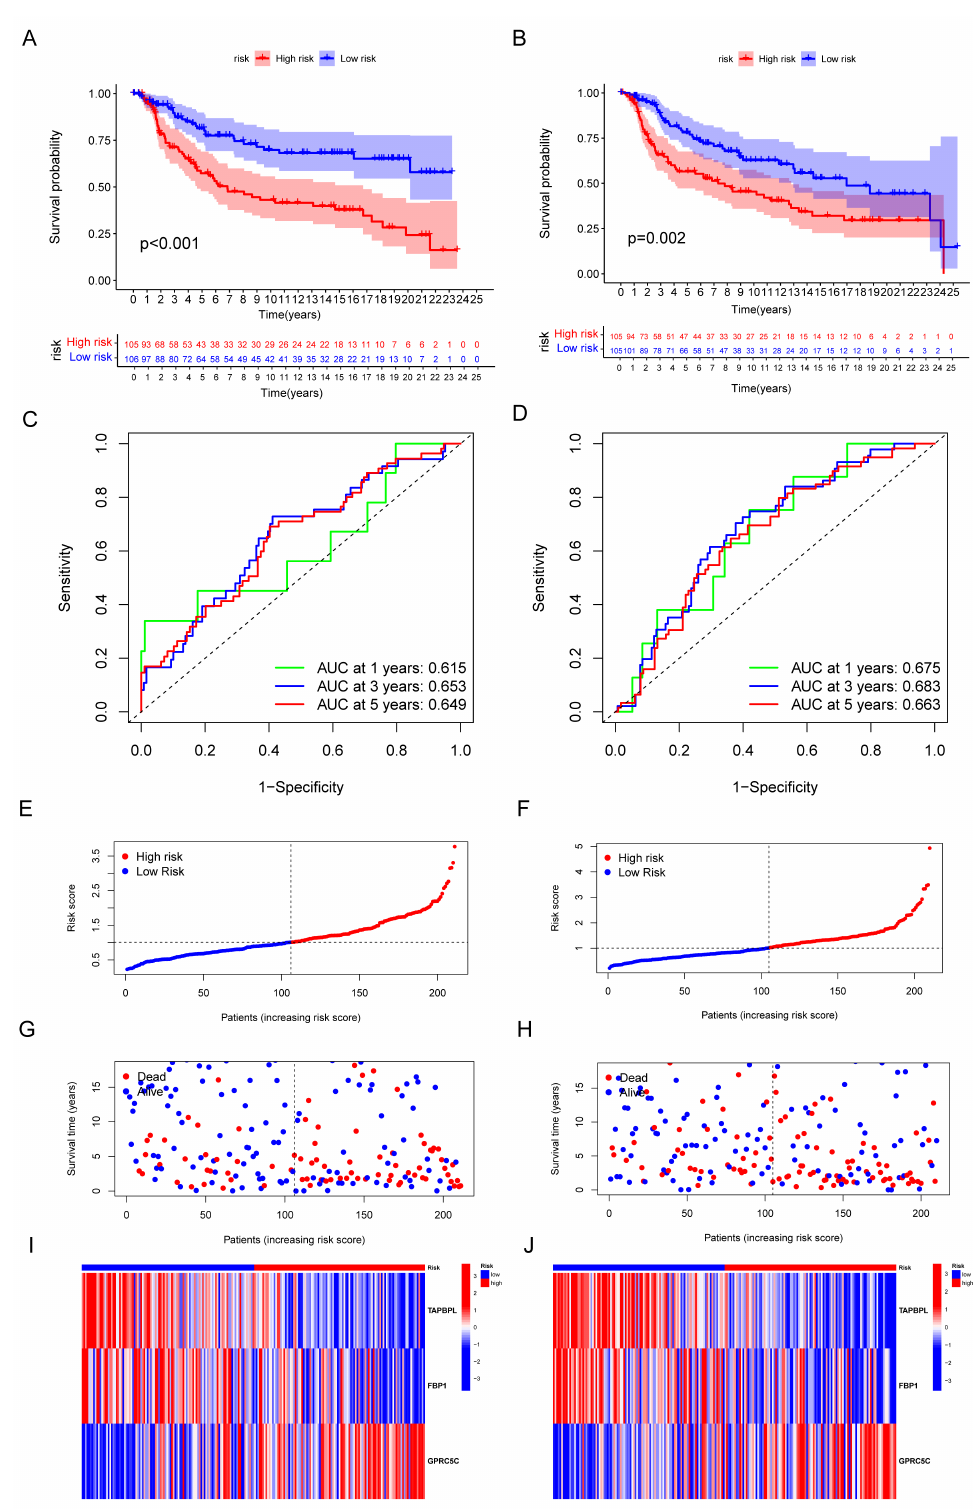
Figure 5. Validation of the efficiency of IRGP. ( A , B ) Kaplan–Meier curves for OS of TNBC patients according to the risk stratification in the training cohort and testing cohort. ( C , D ) ROC analysis for OS prediction at 1 year, 3 years, and 5 years in TNBC patients in the training cohort and testing cohort. ( E , F ) Distribution of risk score for the training group and testing group. ( G , H ) Distribution of survival time of patients in the training and testing groups. ( I , J ) Heatmap depicting the expression of TAPBPL, FBP1, and GPRC5C between high-risk group and the low–risk group in training and testing